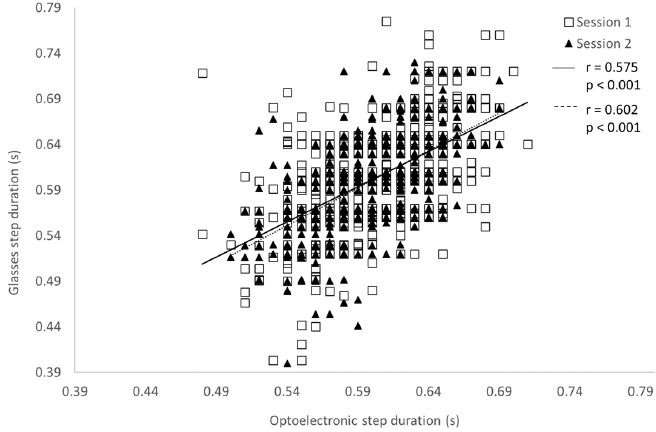
Figure 4. Pearson’s correlation of the step duration measured with the optoelectronic system and the glasses during the 30 s of gait at 0.90 m/s without a cervical collar for both test sessions.